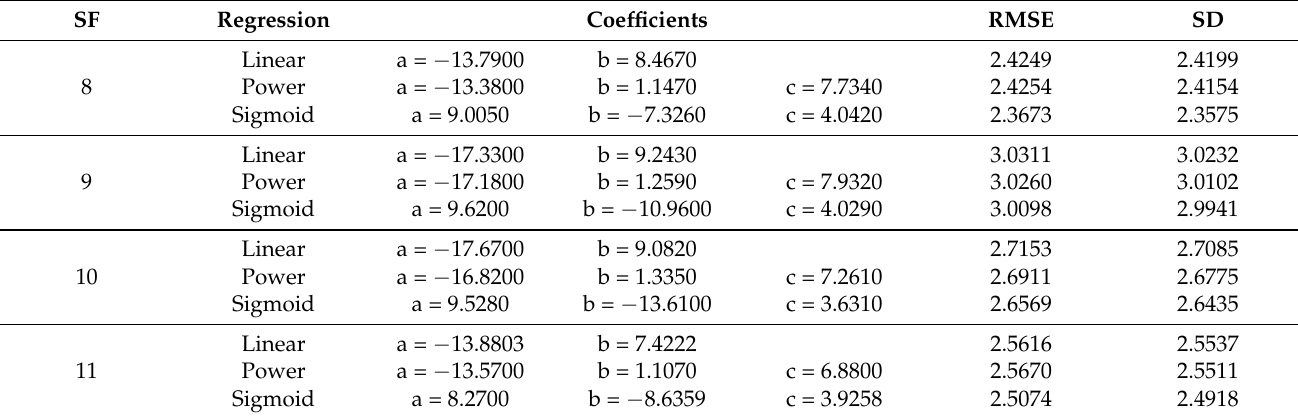
Table 1. RMSE values for downlink regression at 42 m